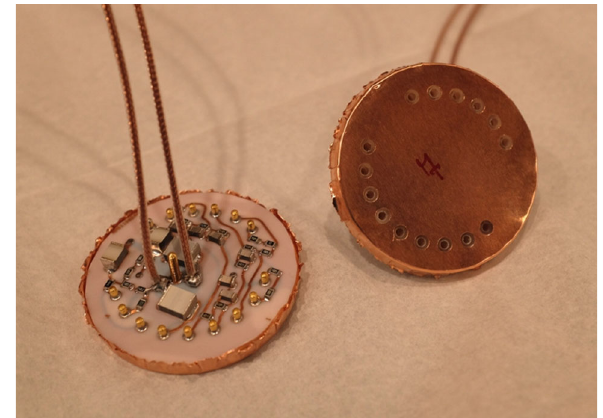
Fig. 13 Voltage divider potted into epoxy